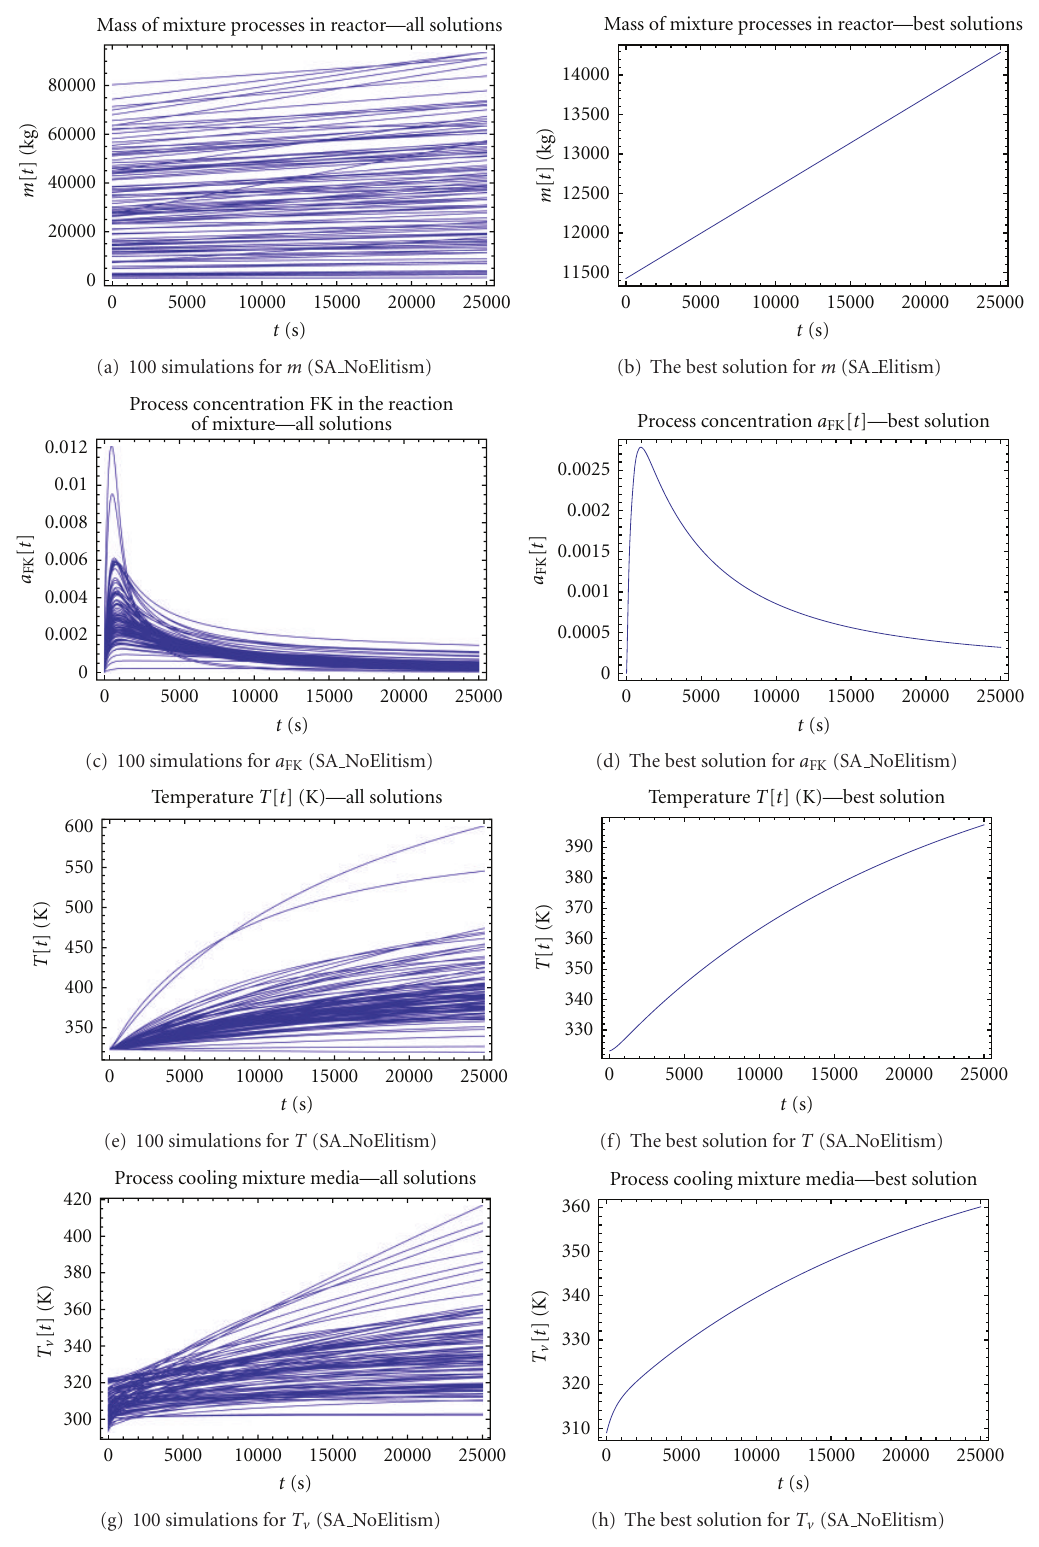
Figure 11: Processes parameters for 100 simulations of SA—version SA